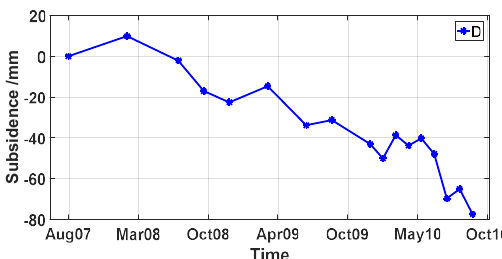
Figure 9. Surface subsidence time series with respect to PS point labeled as D in Figure 4